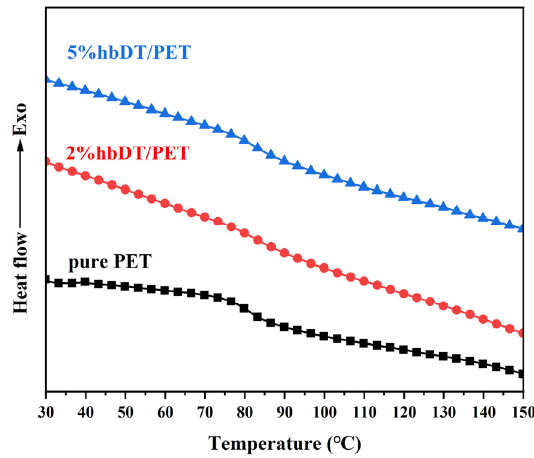
Figure 4. DSC curves of pure PET and different hbDT/PET composites.